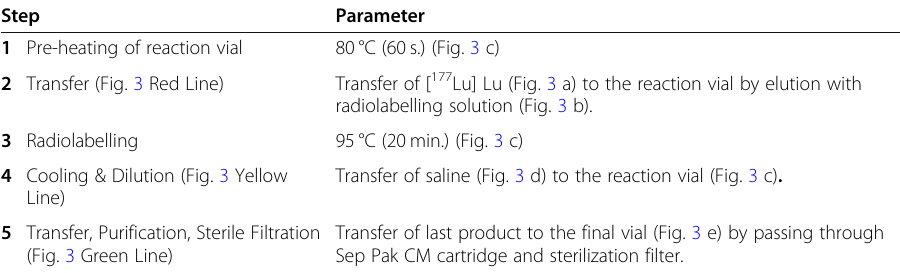
Table 3 General Synthesis Steps